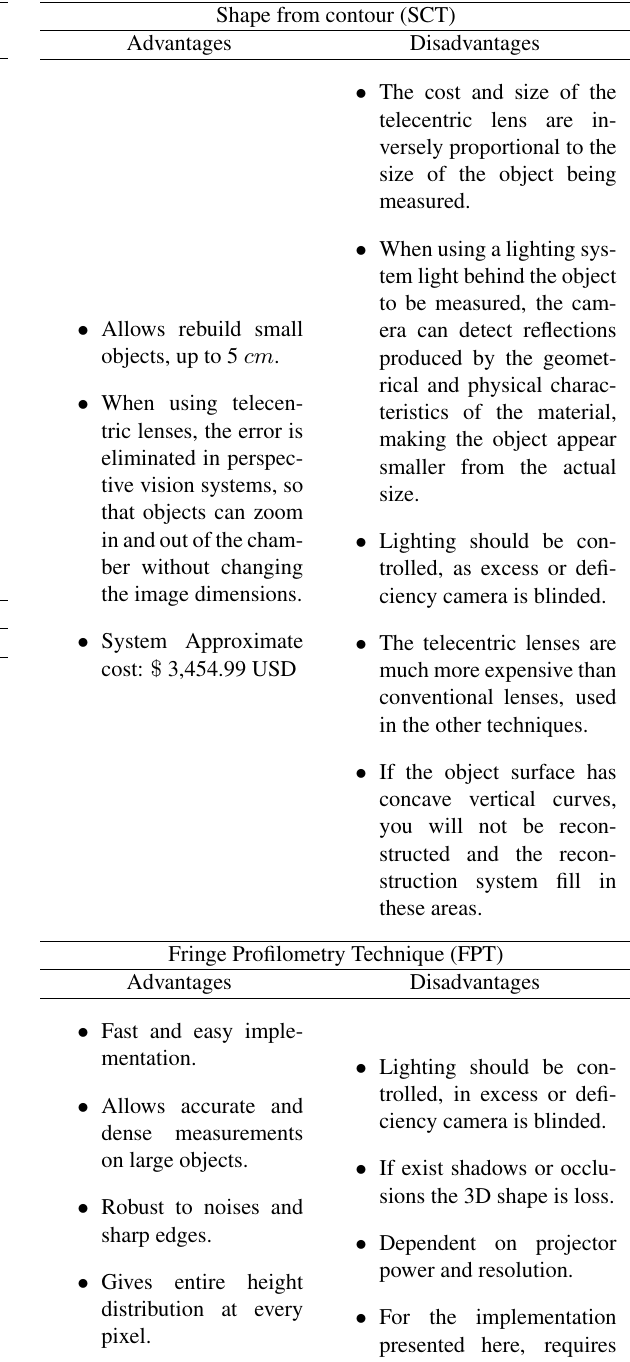
Table 6. Reconstruction techniques PST and AST with advantages and disadvantages of our implemented systems.